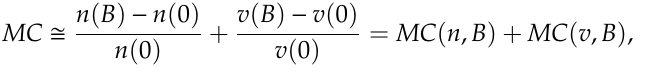
Figure 12. E ff ect of isotope e ff ect on magnetoluminescence e ffi ciency in organic light diodes (OLEDs) Figure 12. Effect of isotope effect on magnetoluminescence efficiency in organic light diodes (OLEDs) by Nguyen et al. [32] with the permission of Nature by Nguyen et al. [32] with the permission of Nature Materials.